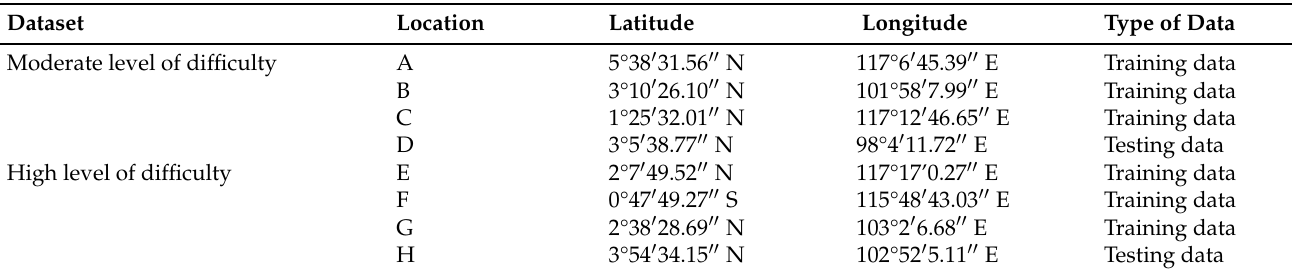
Table 4. Landsat-8 satellite images dataset